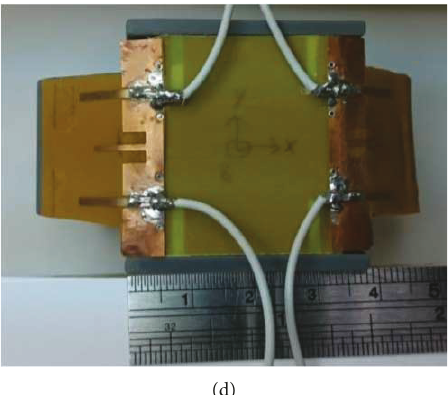
Figure 1: (a) Four-element MIMO antenna embedded in the smartwatch model. (b) Con fi guration, (c) side view, and (d) photograph of the MIMO antenna.